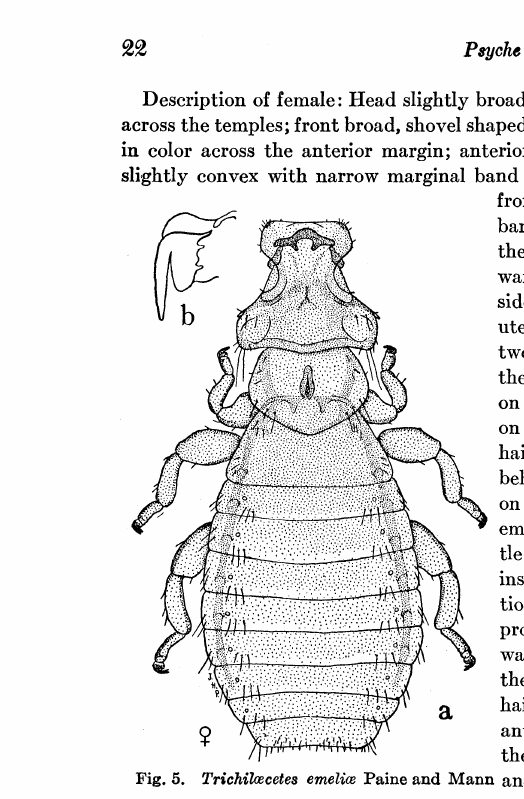
Fig. 5. Trchicetes ernelice :Paine and Mann and several short spines. Occiput sin- uous, bare, with a marginal band. The palettes, in the specimen in hand, have been partially torn away or are quite small though we are inclined to believe that the former is true; the portion present rather darkly colored. Palpi small, not projecting beyond the sides of the head. Prothorax subpentagonal, rounded; posterior margin strongly convex, with a rounded median angle, three strong hairs and one spine toward the lateral angles; above these angles, one marginal and three submarginal spines; a light colored sub- marginal band, continuous with that of the abdomen. Metathorax appearing as the first abdominal segment, with submarginal bands, continuous with those of the abdomen and prothorax and giving off a short branch, running inward along the posterior margin of the prothorax, stopping short of the meson. The metathorax extends under the prothorax for a considerable distance and gives rise to a median, chitinous, spear-shaped thickening which shows plainly through the prothorax. There are several submarginal spines, both in the anterior and posterior lateral angles; posterior margin straight. Legs stout, light in color, with narrow, marginal bands and curious heavy, staple shaped claws. (Fig. 5b). Abdomen, including metathorax, elliptical, narrower than in T. doratophorum Carriker, .with the submarginal bands nearer the margins, the bands